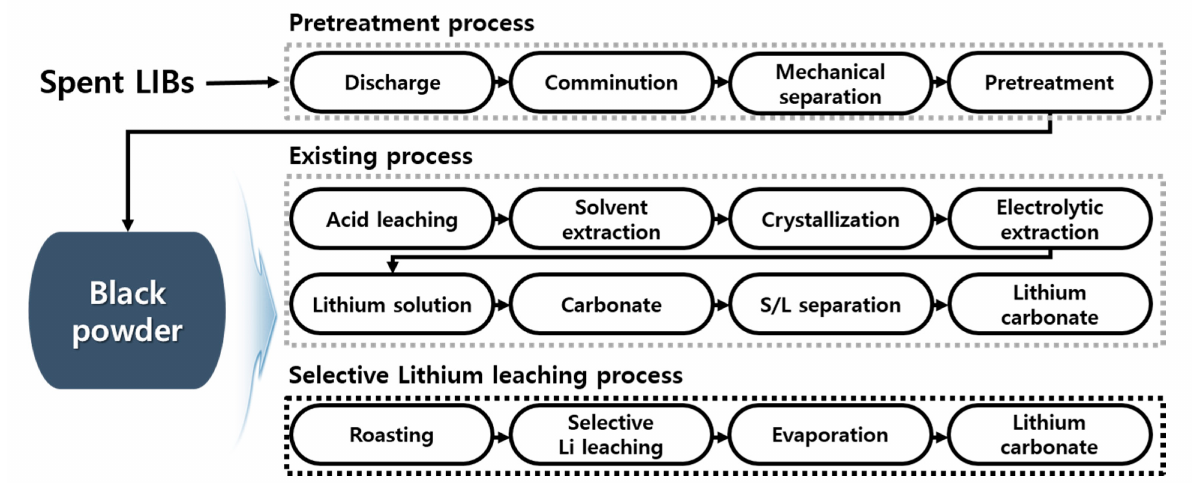
Figure 1. Schematic diagram of existing process and selective lithium leaching